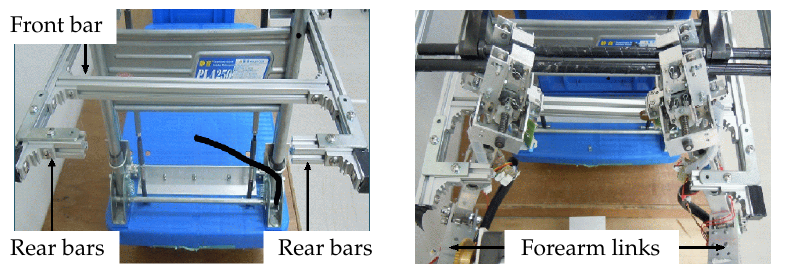
Figure 11. Brake mechanism on the hand cart.